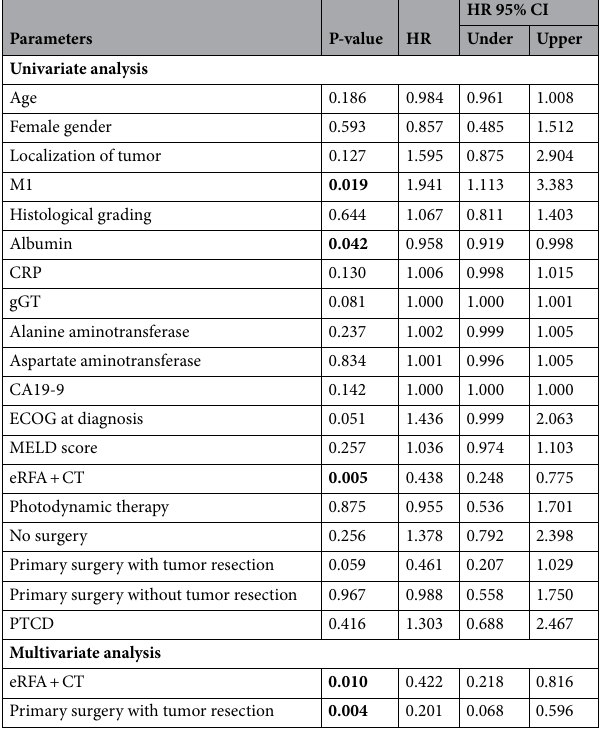
Table 3. Univariate and multivariate time ‐ to ‐ event analysis of baseline and therapy characteristics. CA19-9 carbohydrate antigen 19-9, CRP C-reactive protein, CT chemotherapy, ECOG Eastern Cooperative Oncology Group performance status, eRFA endobiliary radiofrequency ablation, gGT gamma-glutamyltransferase, MELD score model of end stage liver disease score, PTCD percutaneous transhepatic bile duct drainage.